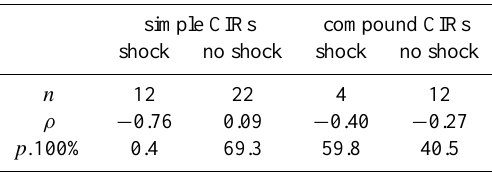
Table 2. Correlation between 0 . 189MeV / n He ion peak inten- sity and compression width for CIRs with simple and compound